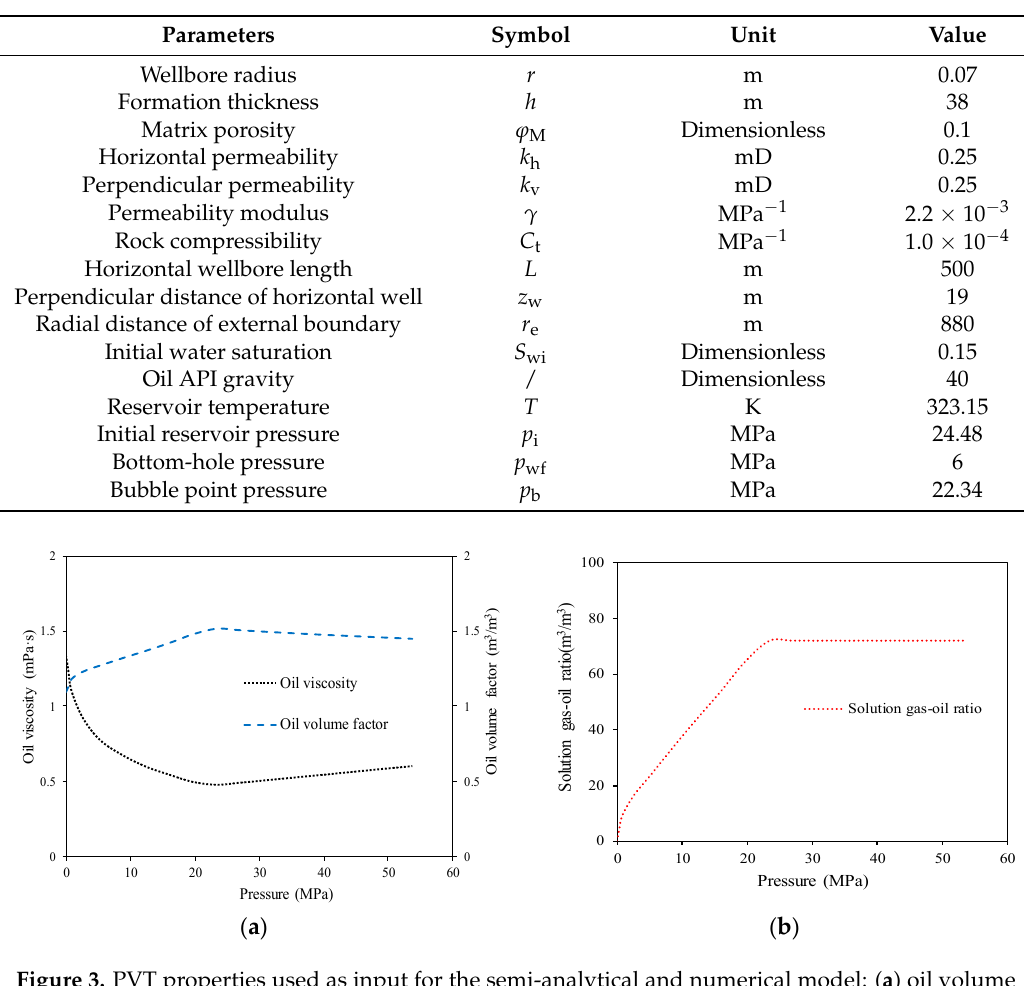
Table 1. Parameters used for validation case.